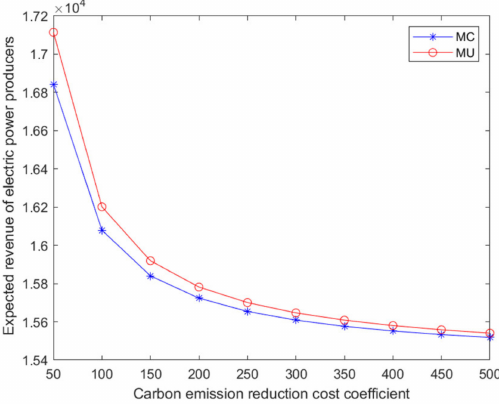
Figure 11. In the condition of centralized decision making in the supply chain with government carbon subsidies and supply chain carbon emission reduction cost sharing, the impact of the carbon emission reduction cost factor on the expected earnings of electric power producers is